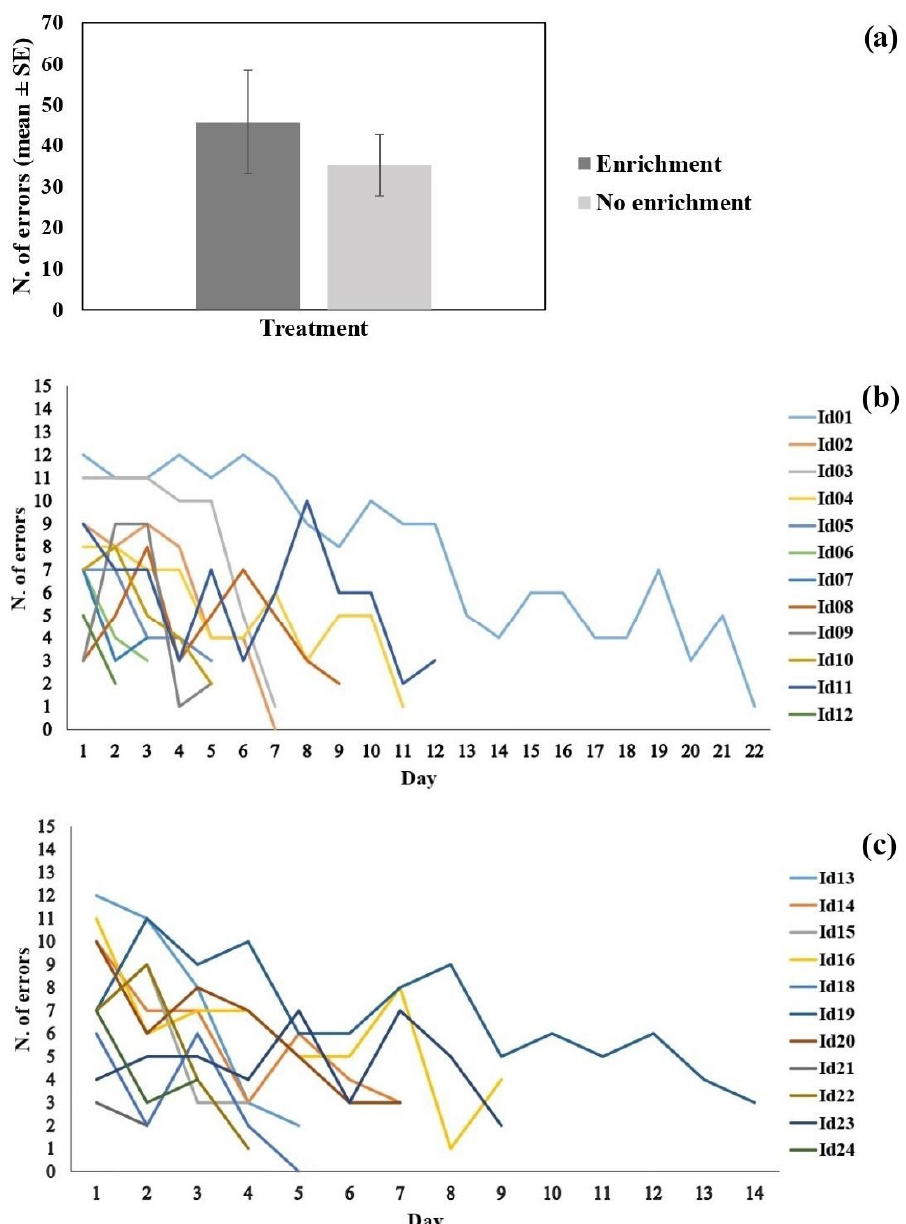
Figure 4. Result of the cognitive flexibility task. ( a ) The number of errors to reach the learning criterion (mean ± SE); the dark bar shows the subjects of the enriched treatment and the light bar the subjects without enrichment. ( b ) The number of errors committed in each day of testing by the fish from the enriched treatment; each line corresponds to an experimental subject. ( c ) The number of errors committed in each day of testing by the fish from the treatment without enrichment; each line corresponds to an experimental subject.